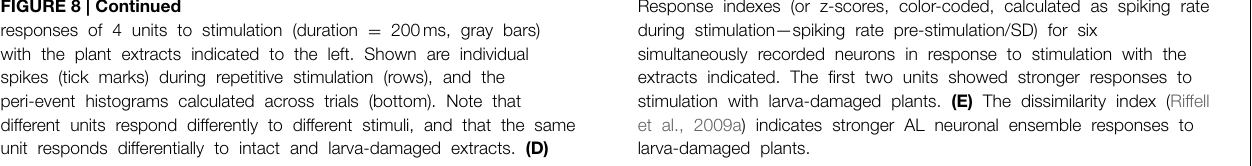
FIGURE 8 | Continued responses of 4 units to stimulation (duration = 200ms, gray bars) with the plant extracts indicated to the left. Shown are individual spikes (tick marks) during repetitive stimulation (rows), and the peri-event histograms calculated across trials (bottom). Note that different units respond differently to different stimuli, and that the same unit responds differentially to intact and larva-damaged extracts.